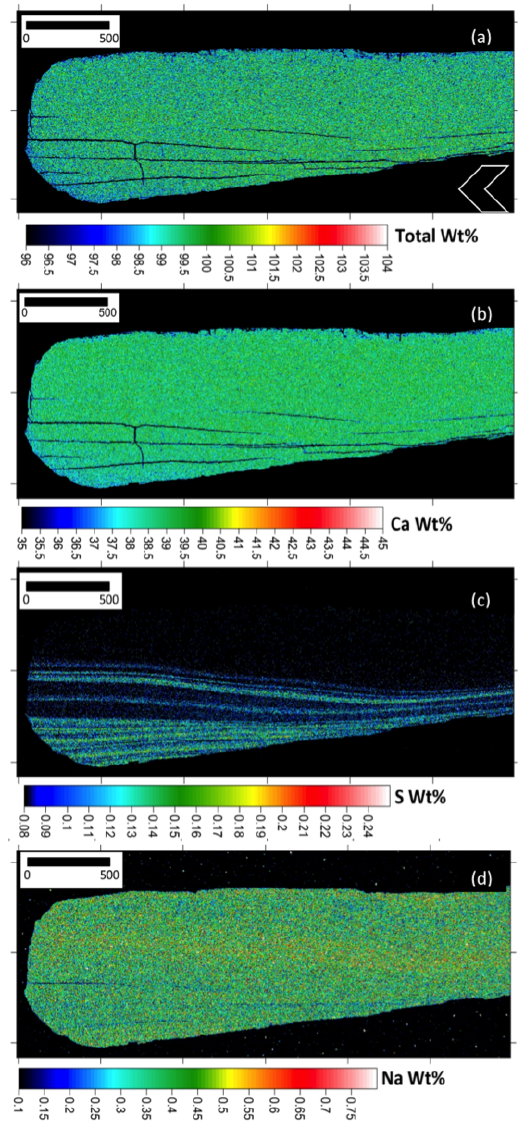
Figure 7. The EPMA elemental map of sample G171, S. biradi- ata , for totals (a) , Ca concentration (b) , S concentration (c) and Na concentration (d) . The Mg and Sr concentrations were below the in- strumental detection limit and are therefore not presented here. The arrow (a) indicates the direction of growth. Note: this shell shows a thick edge compared to the adjacent shell section. The S. biradiata shell thickness is variable along the cross